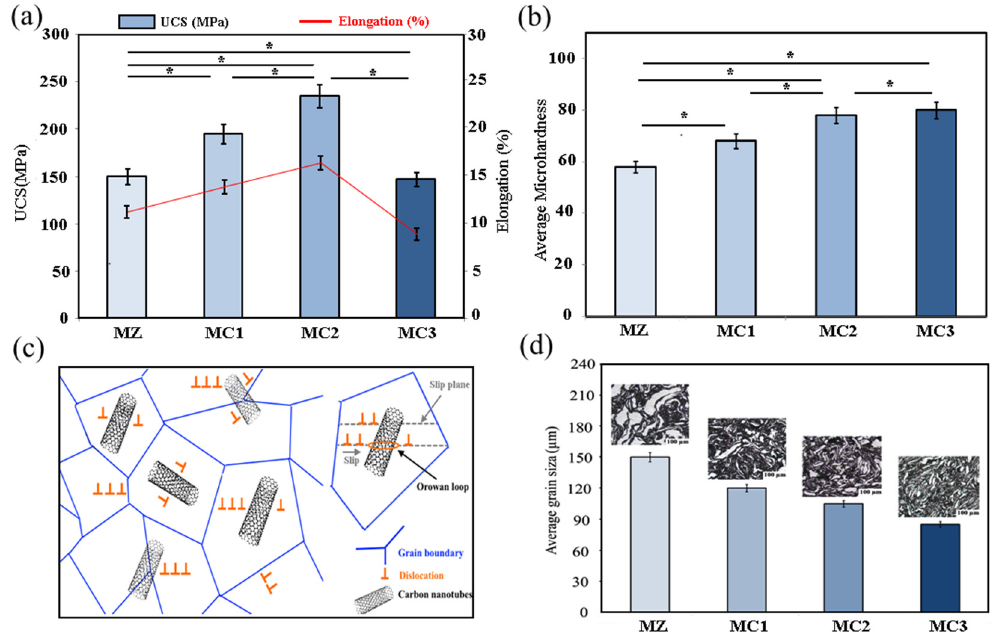
Figure 8. ( a ) Microhardness value, ( b ) ultimate compressive strength (UCS) value of MZ, MC1, MC2 and MC3 composites, ( c ) schematic showing the Orowan looping mechanism after dislocations gliding over and bypassing the CNTs, ( d ) OM image and grain size calculations of MZ, MC1, MC2 and MC3 composites.